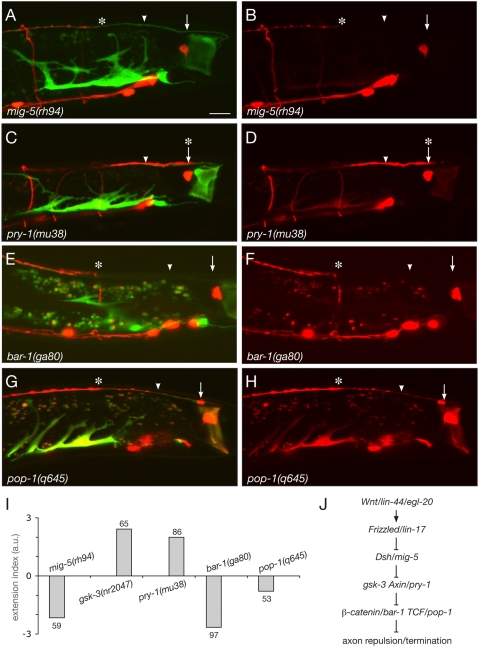
Mutants in the canonical Wnt pathway display D-type axon guidance defects.(A–H) Posterior D-type axons underextend in mig-5/Dsh mutants (A,B), bar-1/β-catenin mutants (E,F) and pop-1/TCF mutants (G,H), but overextend in pry-1/Axin mutants (C,D). In all images, the arrow and arrowhead indicate the wild-type termination points, and the asterisk indicates the abnormal termination point of posterior D-type axons. (I) Extension index for mutants in components of the canonical Wnt pathway. (J) Genetic pathway controlling D-type axon guidance, inferred from mutant analysis. Note that Dsh acts negatively in this pathway, opposite to its predicted role in the canonical pathway. Scale bar, 10 µm. a.u.: arbitrary units.